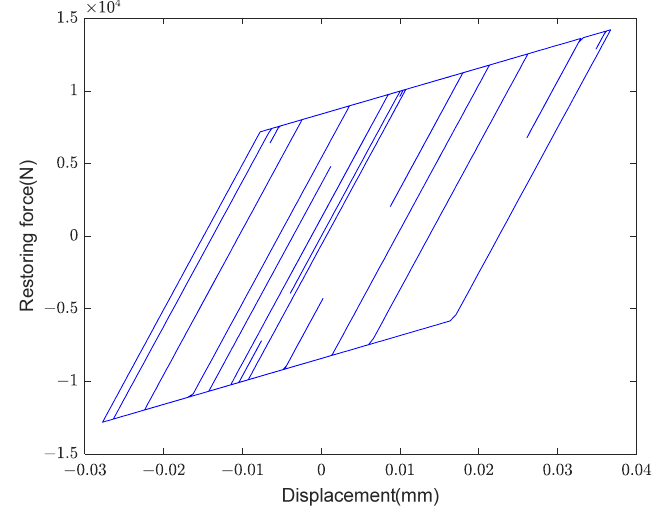
Figure 5. Hysteresis loop of the base